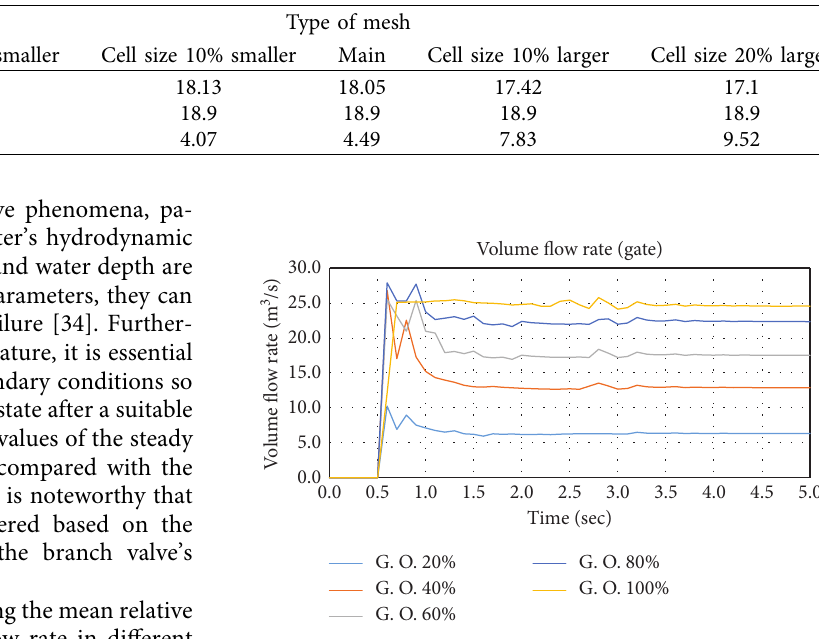
Figure 6: Boundary conditions applied in flow simulation in the bottom outlets. Table 3: Mesh sensitivity analysis.